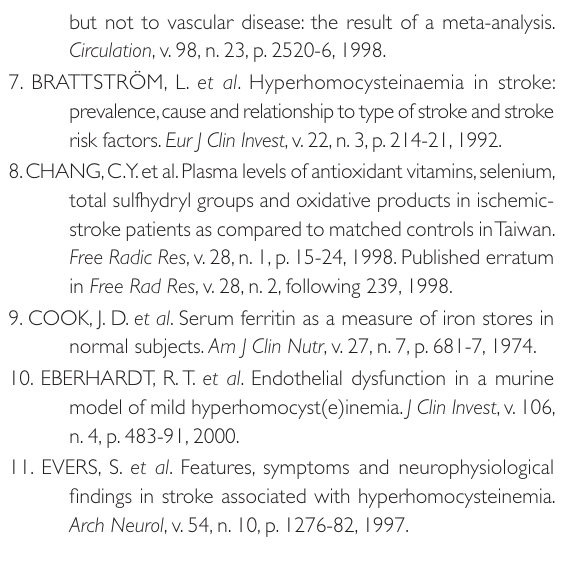
but not to vascular disease: the result of a